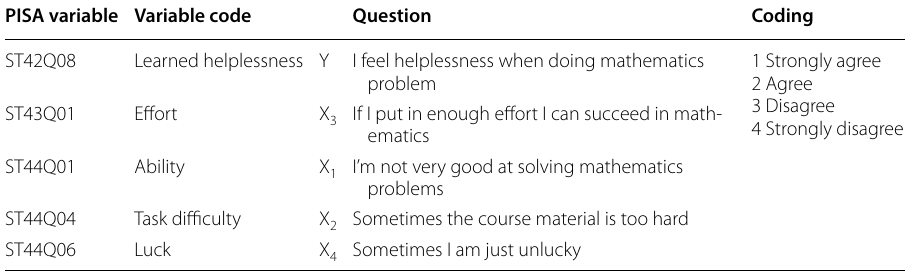
Table 1 Five questions for learned helplessness and locus of control PISA variable Variable code Question